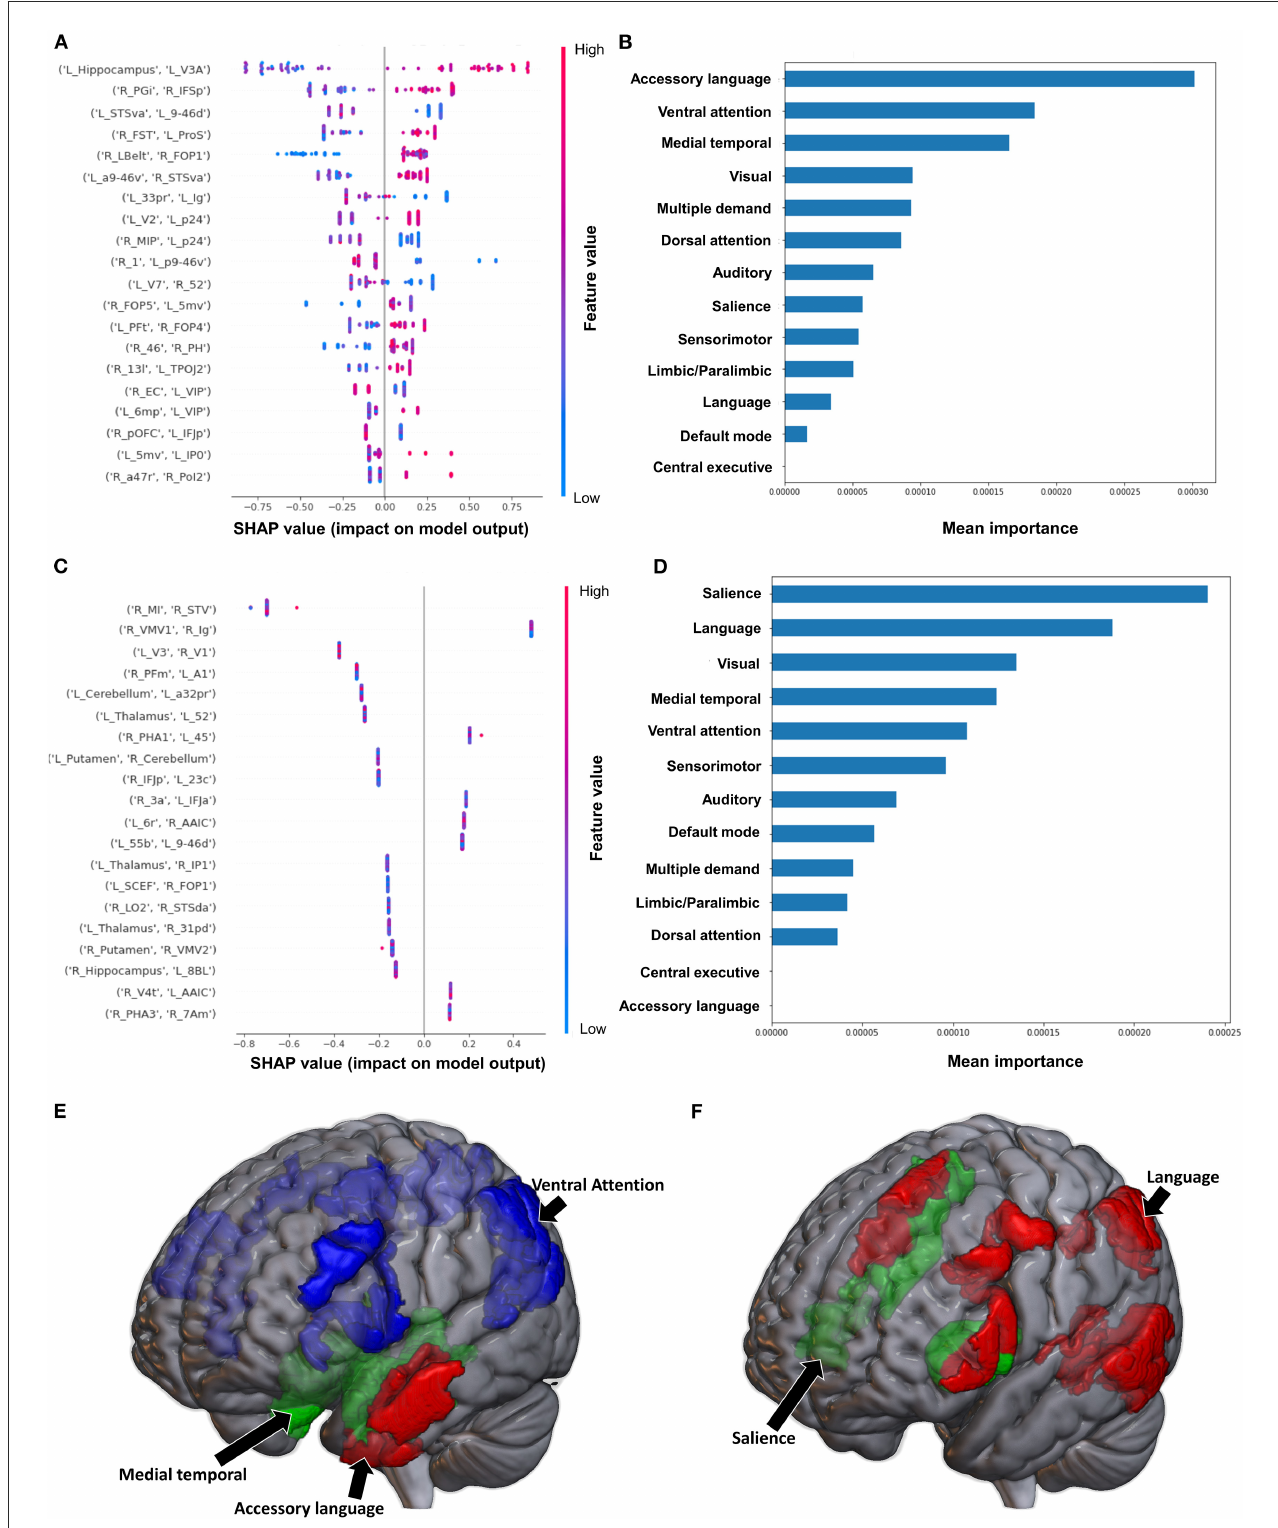
FIGURE2 Feature Importance Analysis of the models classifying the Fugl Meyer assessment—lower extremity based on functional connectivity at the (A) individual brain region level, and (B) the network level; and based on structural connectivity at the (C) the individual brain region level, and (D) the network level. The networks contributing most to the models’ classifications, based on (E) functional connectivity, and (F) structural connectivity, have also been visualized on brain